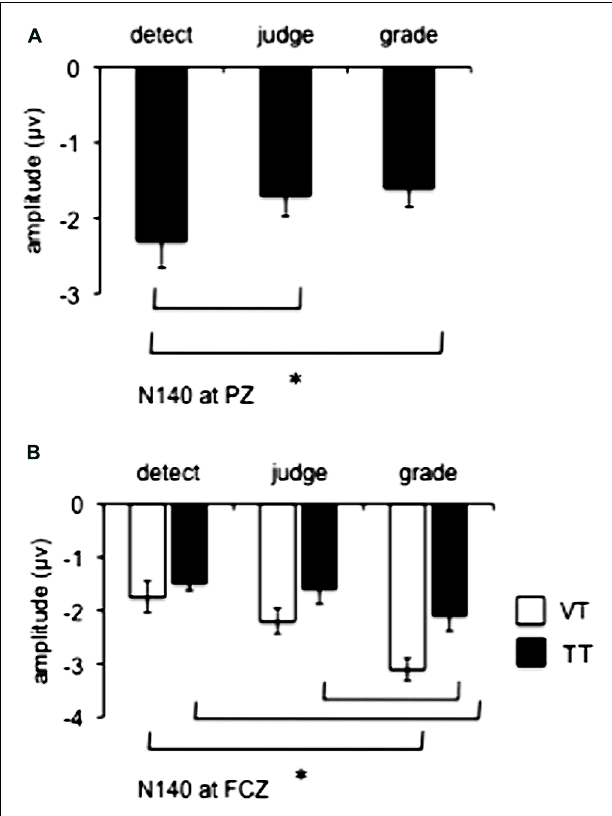
FIGURE 4 | Group means ( n = 10) for N140 amplitude measured at PZ (A) and FCZ (B) in Experiment 1. White bars represent group data for the crossmodal visual + tactileTT task condition (VT), black bars represent group data for the unimodal tactile condition (TT). Error bars show SE. * Denotes significance ( p < 0.05) between the specific conditions marked by the brackets (details in the text).